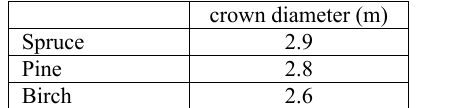
Table 2. The values of applied mean crown diameters. ( Korpela et al., 2014).